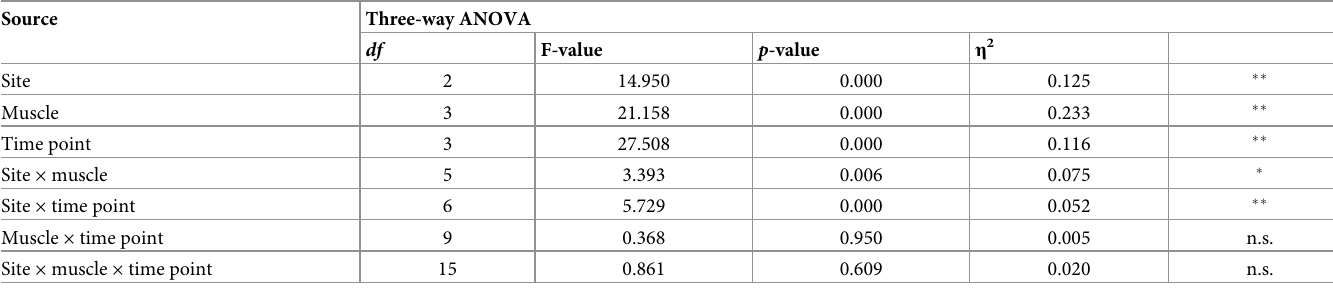
Table 1. Results of statistical analyses for the T 2 values.